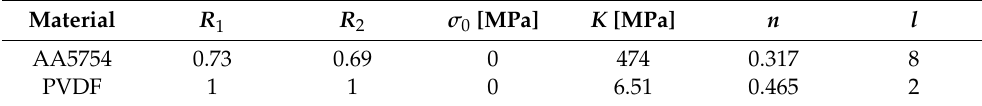
Table 1. Mechanical properties of AA5754 and PVDF.